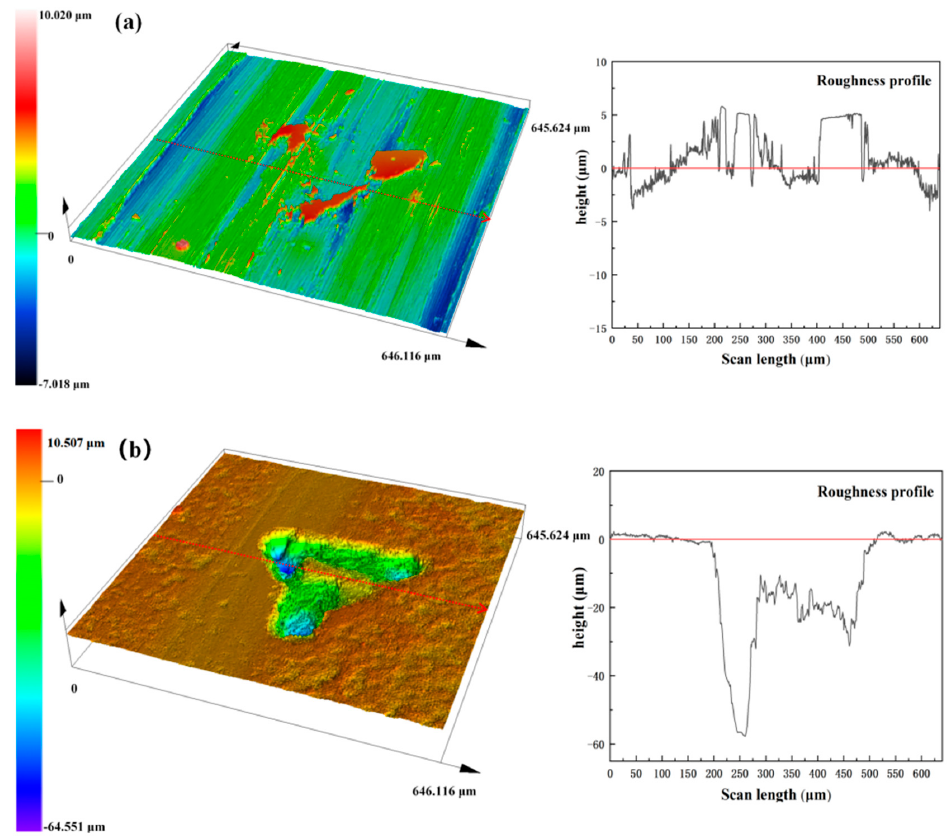
Figure 14. Three - dimensional topography of the worn surface of textured samples. ( a ) TA group. ( b ) NA group.